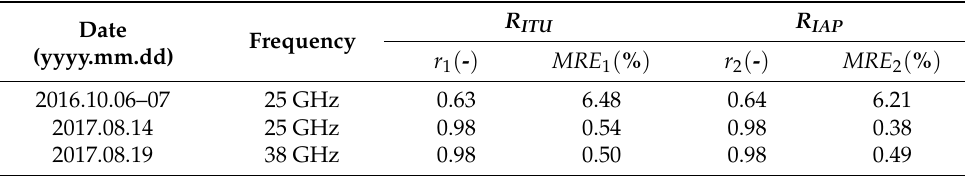
Table 3. Correlation and mean relative error of the rainfall rate recorded by a rain gauge and estimated rainfall rate based on the power law coefficients from the ITU ( R ITU ) or locally derived coefficients at IAP, CAS in Beijing ( R IAP